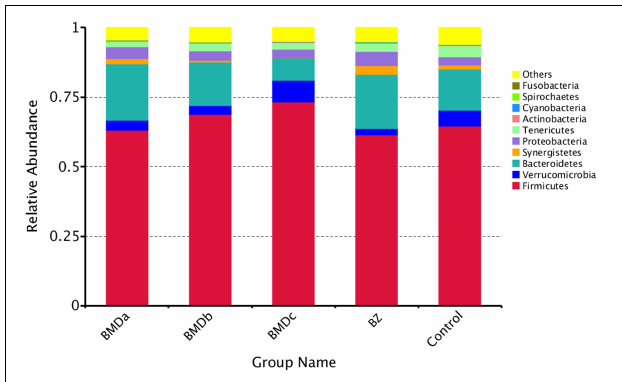
FIGURE 3 | Percentage composition of the top 10 predominant phyla in the cecal content.